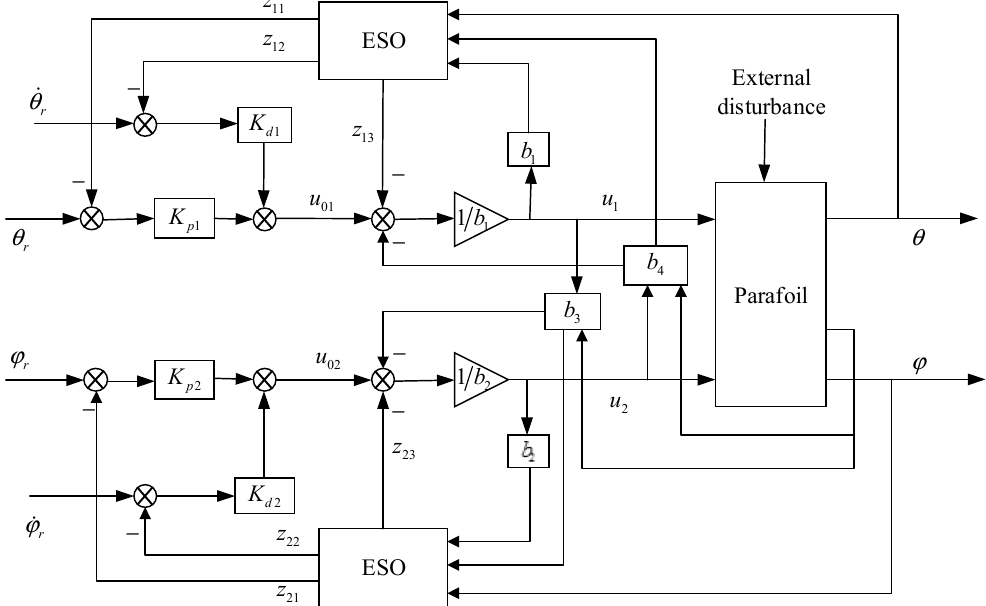
Figure 5. Block diagram of the double close-loop decoupled controller.